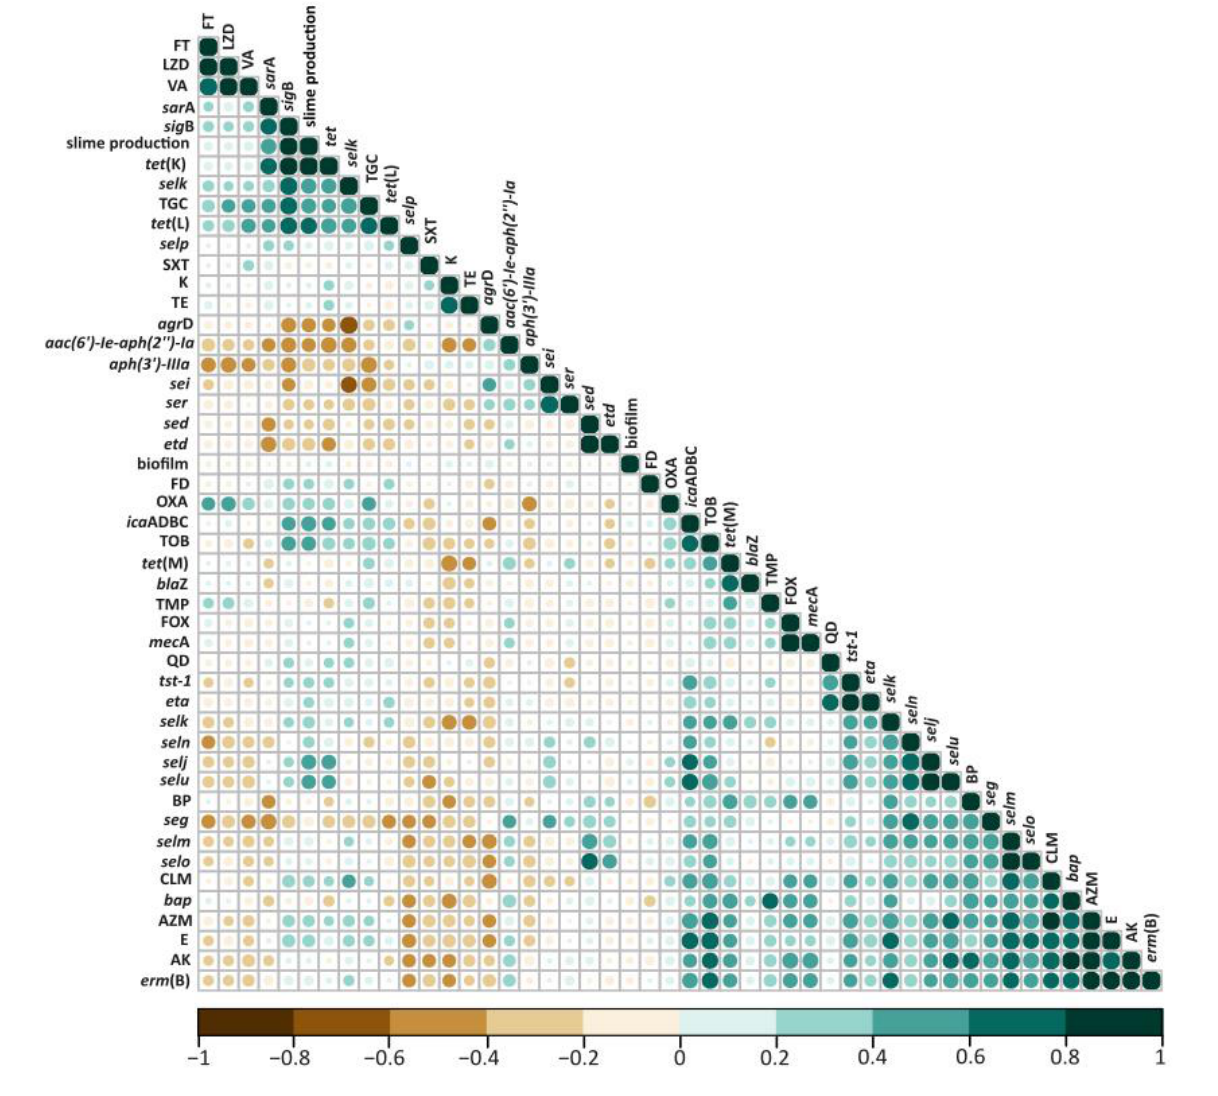
Figure 1. Correlation matrix indicating all correlations between pairs of genetic or phenotypic determinants (resistance phenotypes).